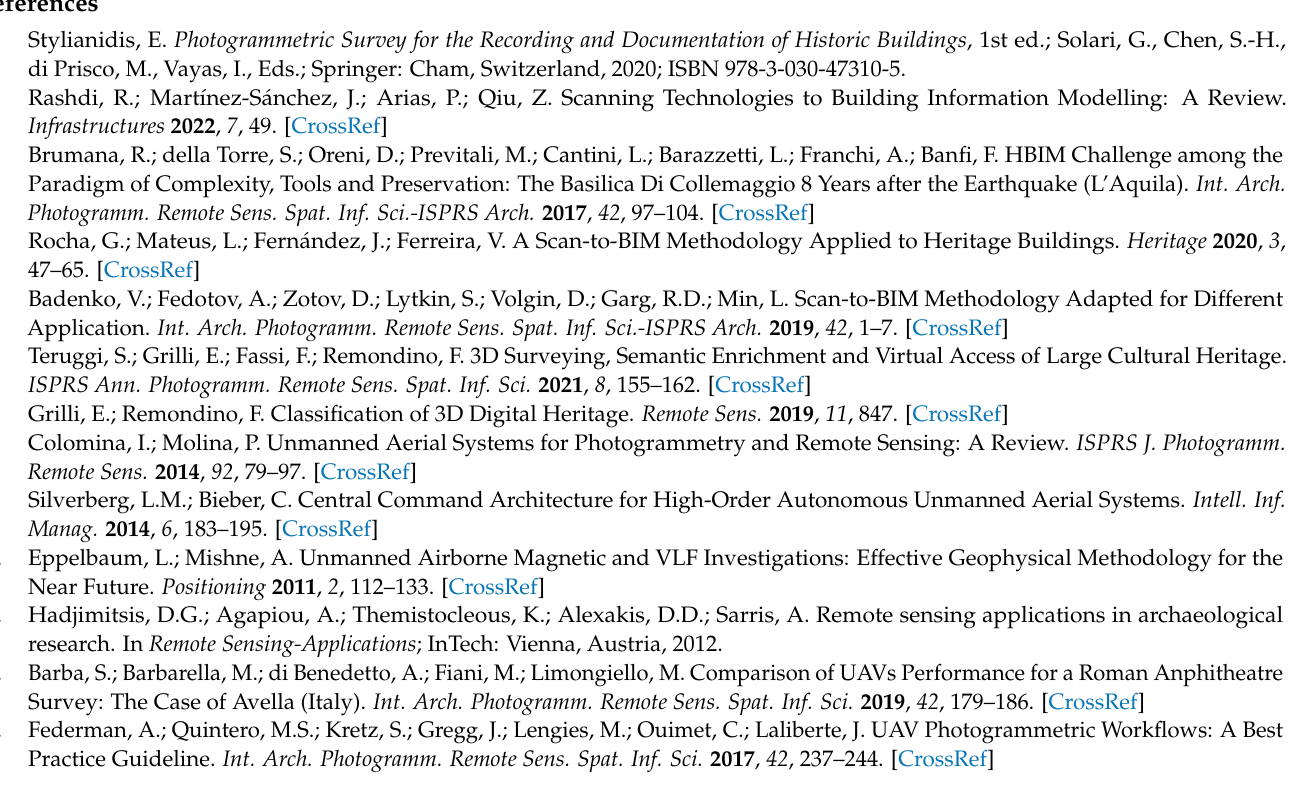
Calabria Region—“ KROTON LAB